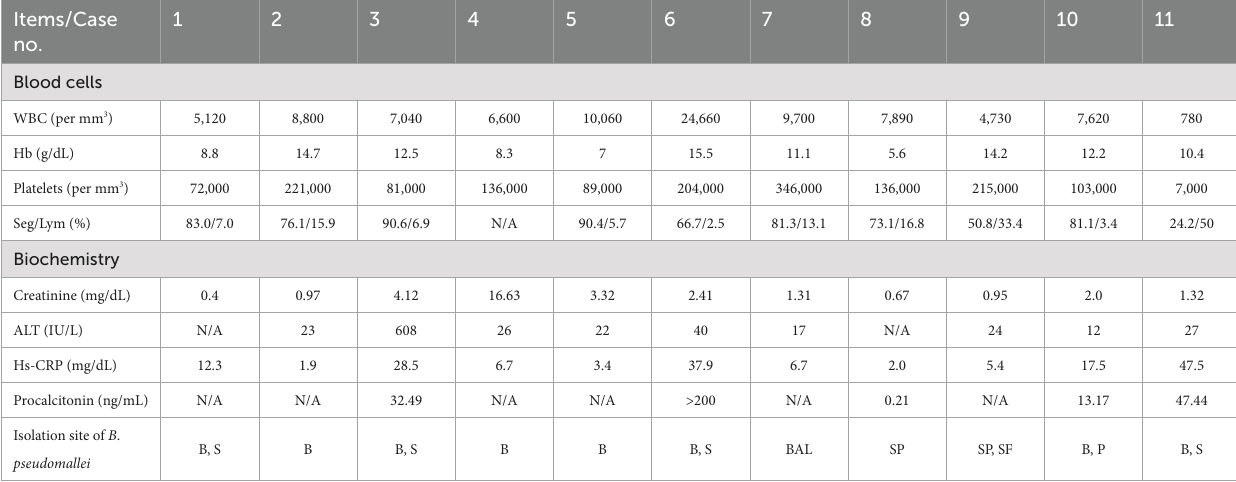
TABLE 2 The laboratory data at admission among 11 patients with laboratory-confirmed mellioidosis. Items/Case